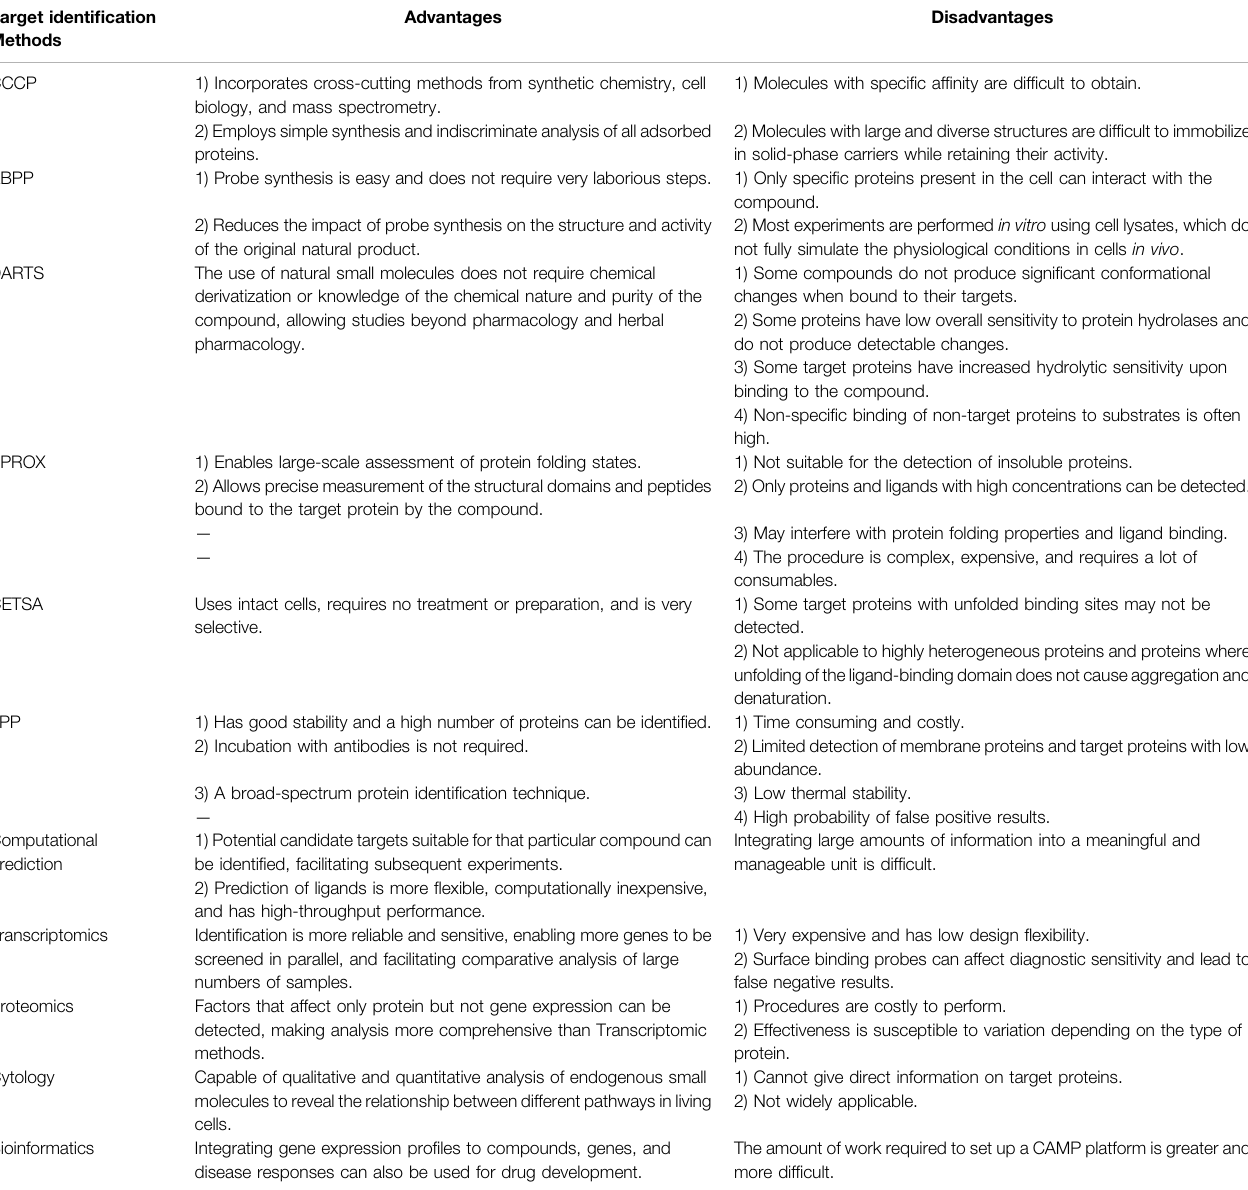
TABLE 2 | The advantages and disadvantages of currently available target identi fi cation